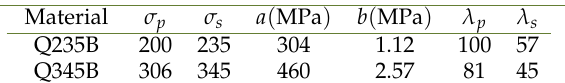
Fig. 5. The failure mode of test angle steel.